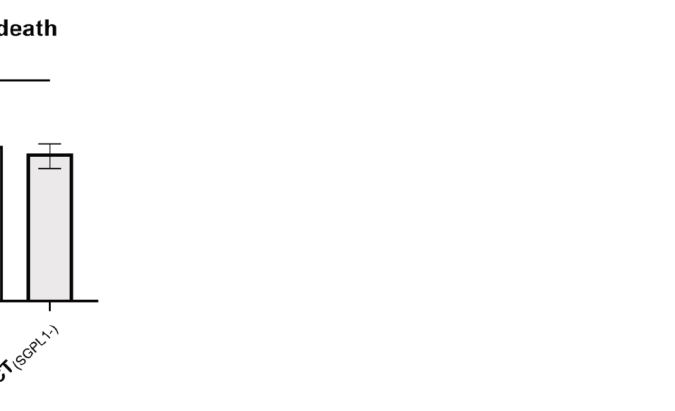
Figure 5. Cellular death by apoptosis (as measured by ELISA apoptosis assay) in SPHK1 - and SGPL1 -silenced human colon tumor cells. Values are medians +/- interquartile ranges (n = 4); * p < 0.05 vs. control (HCT (CON) ).